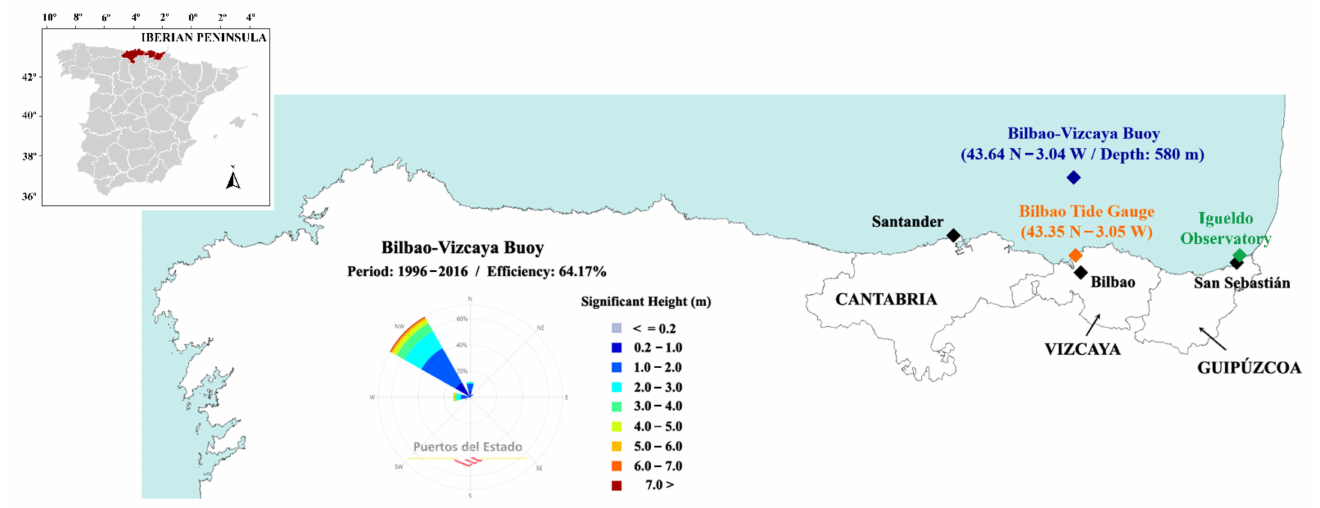
Figure 1. Study area and location of data sources (tide gauge, buoy, and meteorological